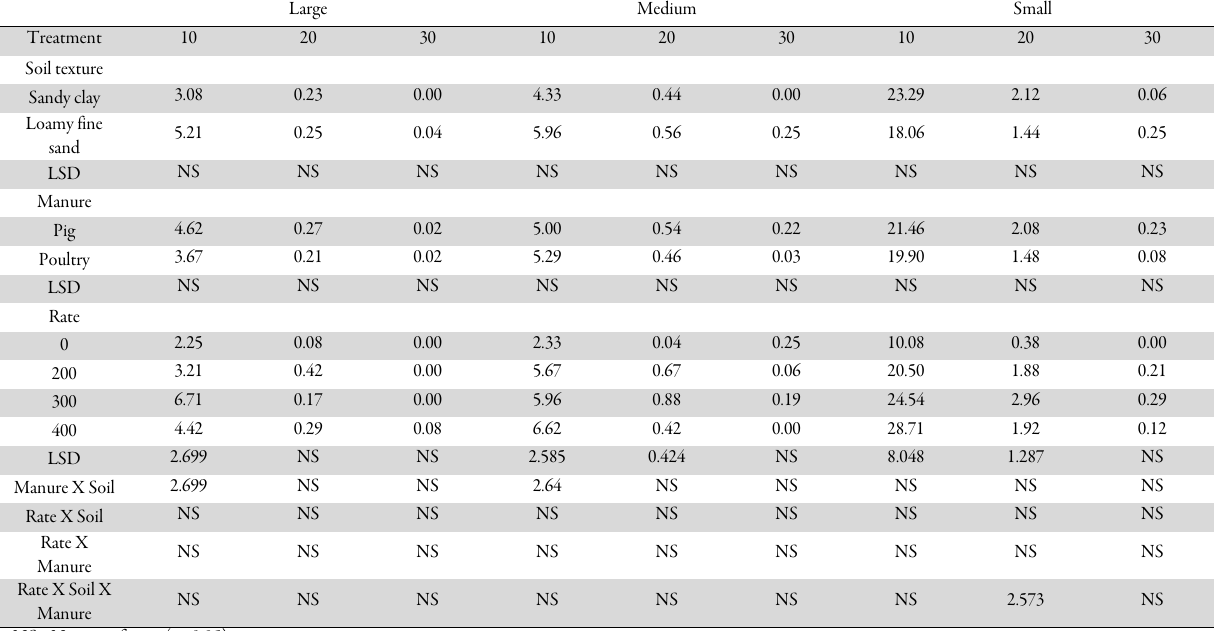
Table 6. Effect of soil texture and rates (g pot -1 ) of poultry and pig manure on number of large, medium and small tiger nut tubers at 10, 20 and 30 cm soil depth at harvest